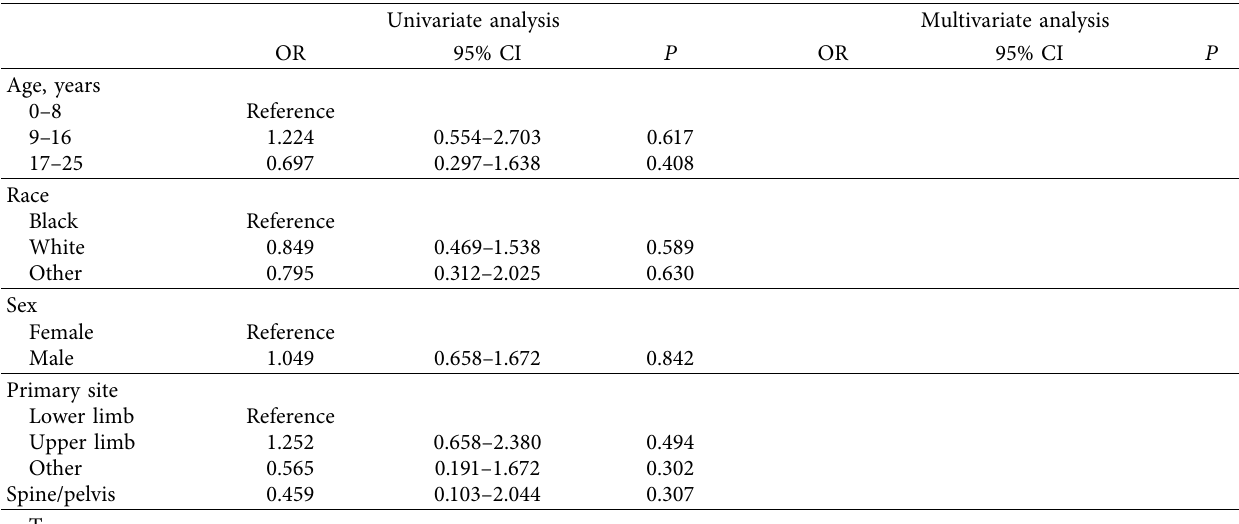
Table 2: Univariate and multivariate logistic analyses of LM in osteosarcoma patients. Univariate analysis Multivariate